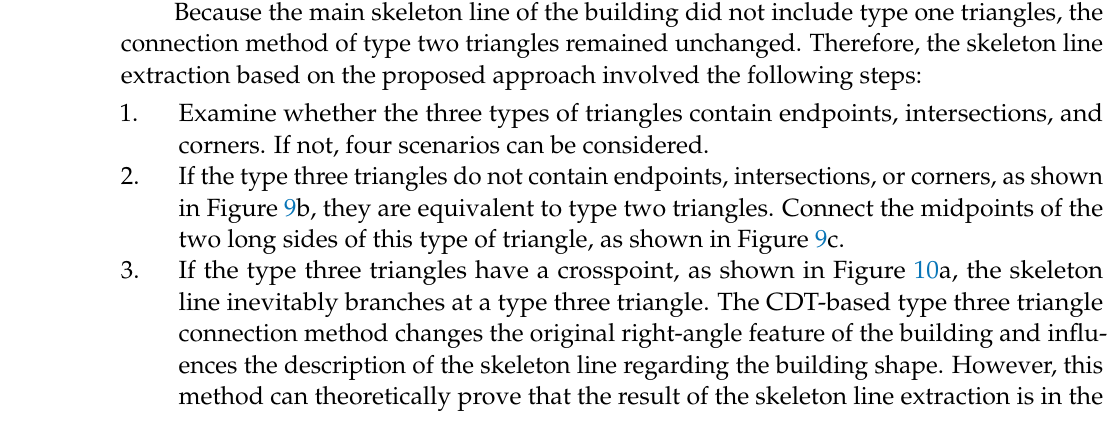
Figure 9. Three type three triangles without endpoints, corners, or intersections. ( a ) Delaunay tri- angles classification results; ( b ) Overlay of Rosenfeld and CDT results; ( c ) Overlay of Rosenfeld, CDT and VRDI results. 3.